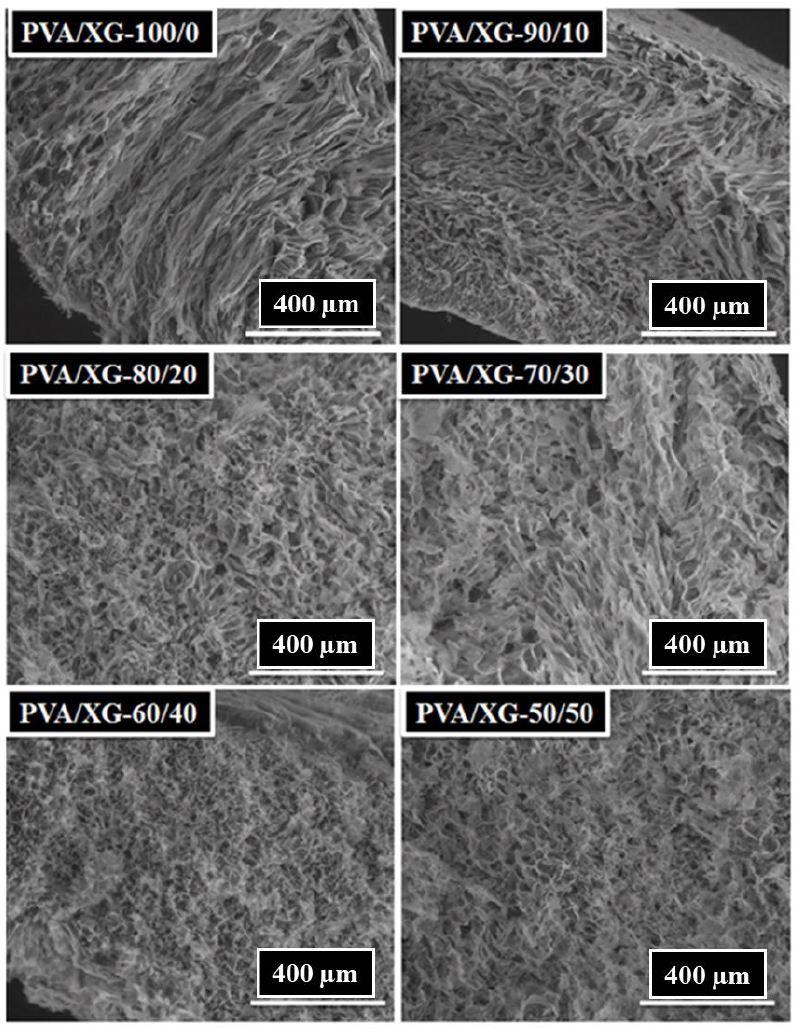
Figure 4. SEM images of PVA/XG